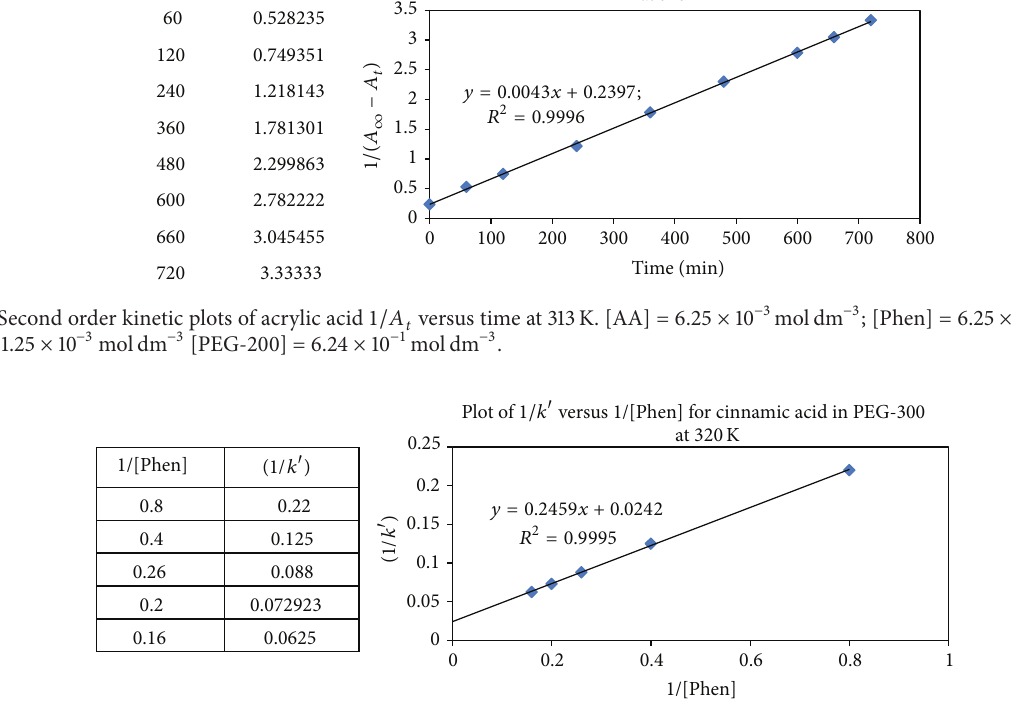
Figure 5: Effect of variation of [Phen] on first order 𝑘 󸀠 of cinnamic acid in PEG-300, medium at 320